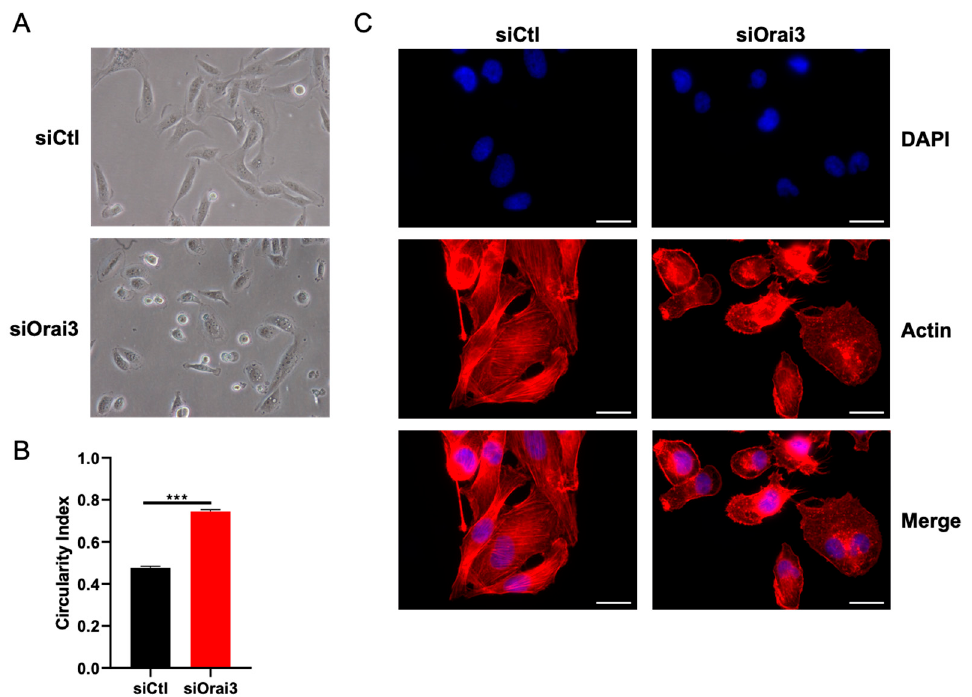
Figure 5. Orai3 modulates cell morphology. ( A , B ). siOrai3 MDA-231 cells present a rounded morphology. Representative images ( A ) and calculation of the circularity index ( B ) of MDA-231 cell morphology (siCtl n = 246; siOrai3 n = 312; N = 3; *** p < 0.001). ( C ). Actin cytoskeleton architecture depends on Orai3 expression levels. Fluorescent rhodamine phalloidin staining reveals the actin architecture of siCtl and siOrai3 MDA-231 cells (N = 3). Scale bar: 10 µ m.